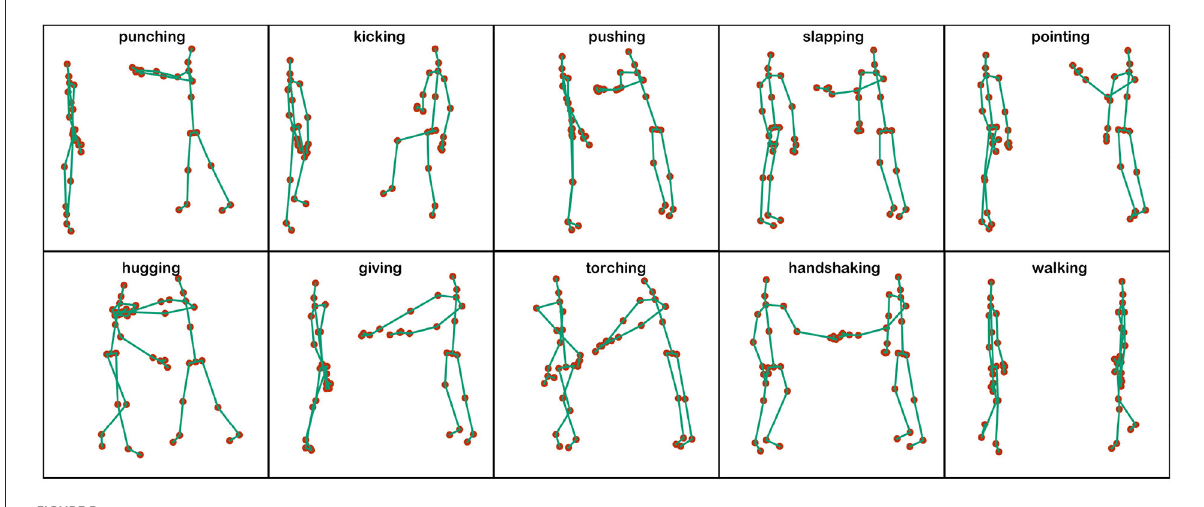
FIGURE5 Visual representation of 10 types of human violence actions.